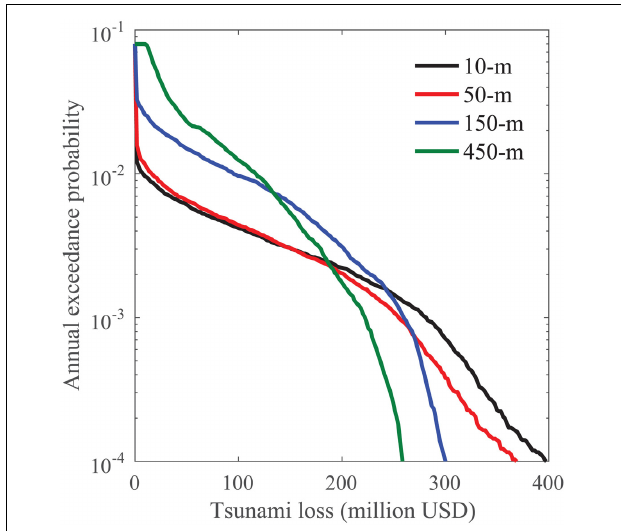
FIGURE 12 | Tsunami loss curves for Onagawa.